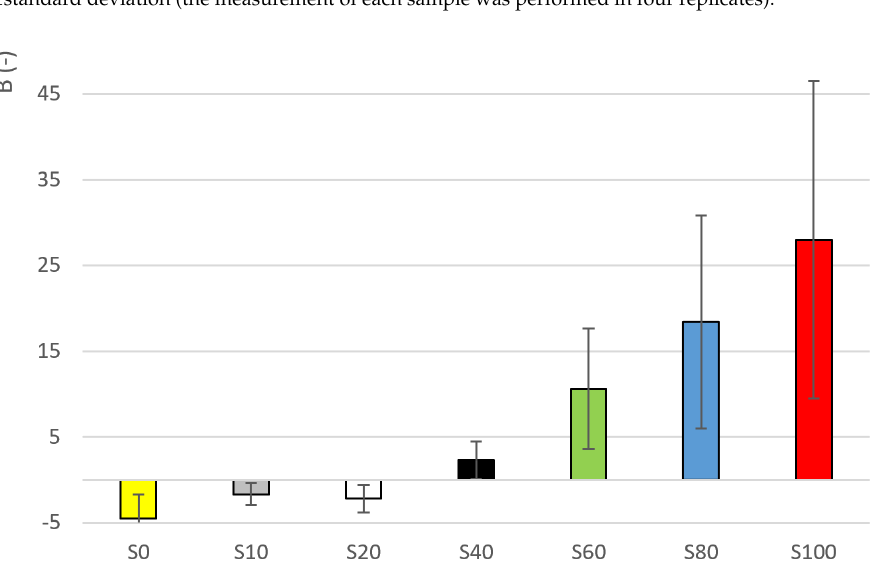
± standard deviation (the measurement of each sample was performed in four replicates).